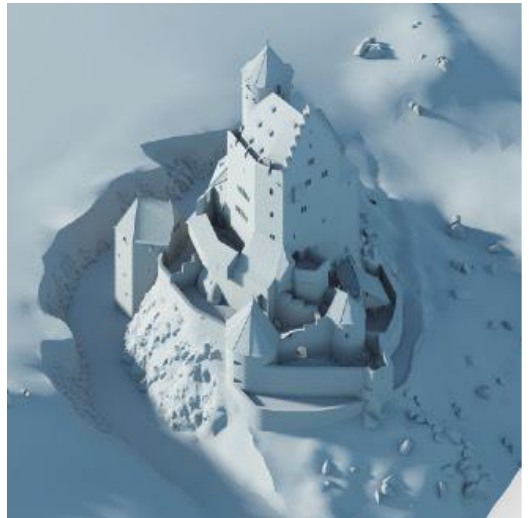
Figure 4: 3D reconstructed model suggested for the Kagenfels castle, as it was in 1550.